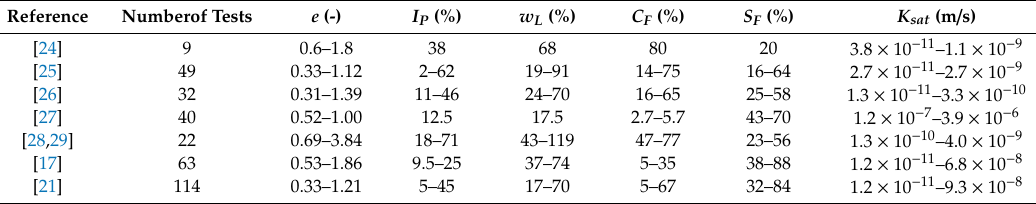
Table 2. Main geotechnical characteristics of tested soils